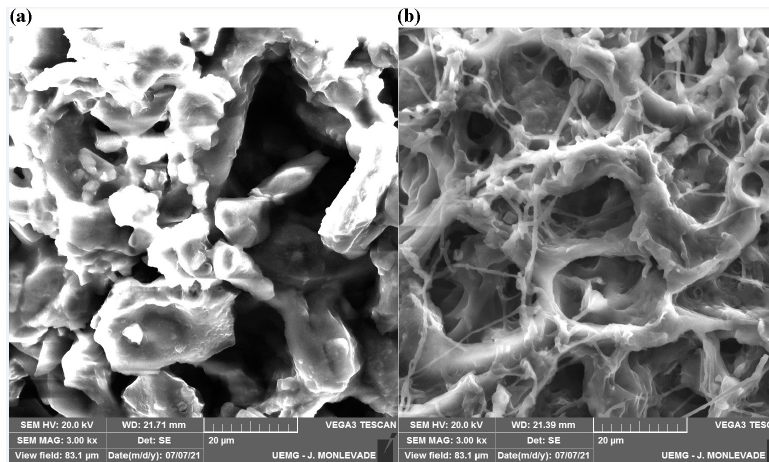
Figure 3. SEM images of SCG (a) and BSC